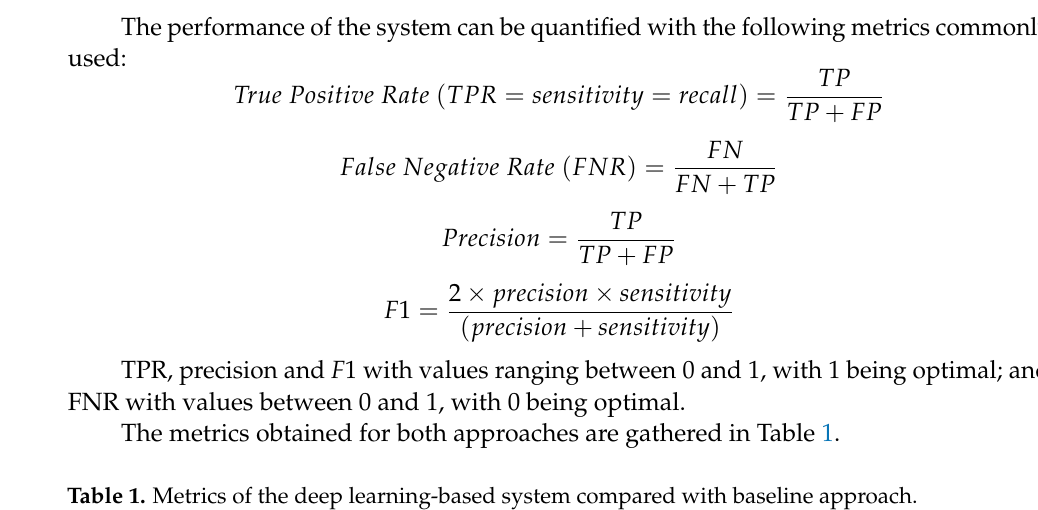
Table 1. Metrics of the deep learning-based system compared with baseline approach. Method TPR FNR Precision Baseline (classical image processing)